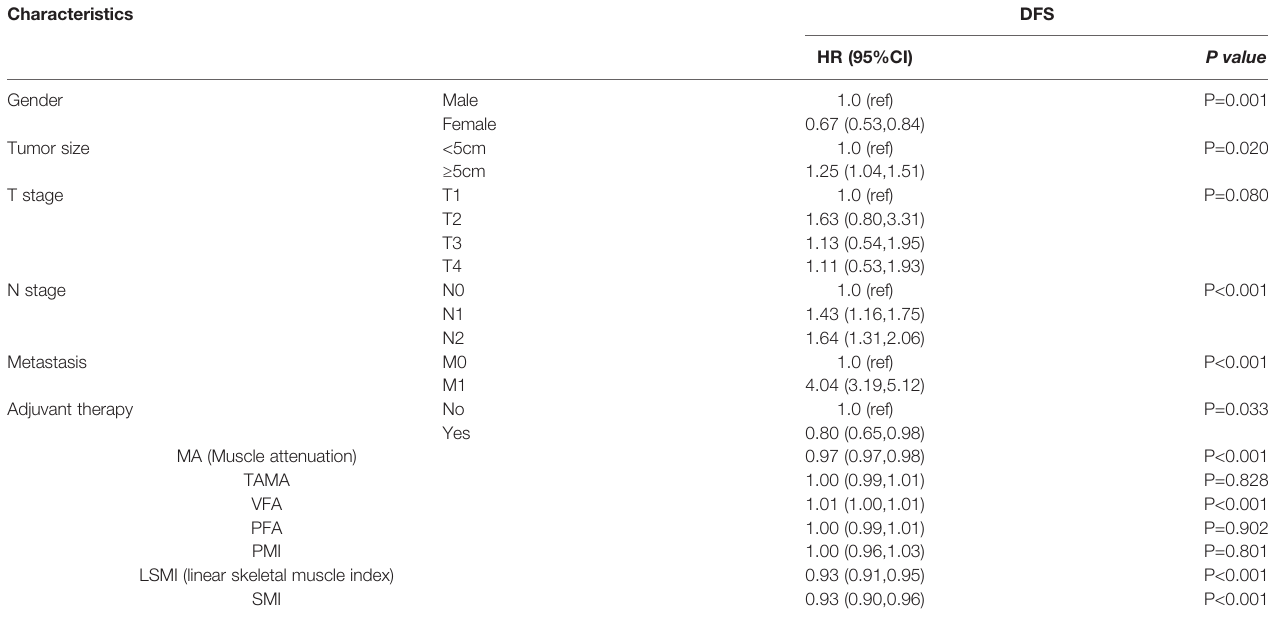
TABLE 4 | Multivariate cox proportional hazard analysis for risk factors of patients ’ prognosis (DFS).